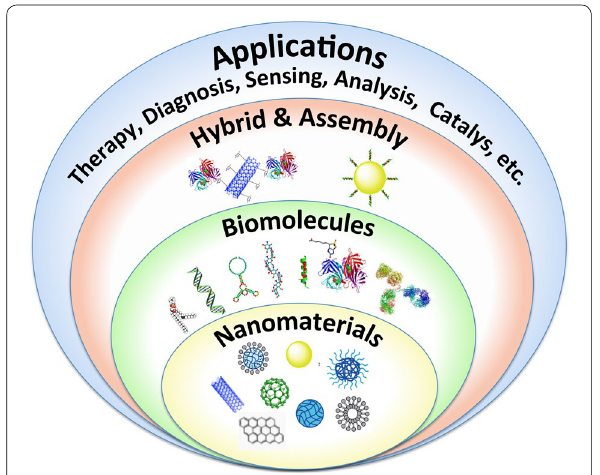
Fig. 1 A summary of nanobiomaterials and their